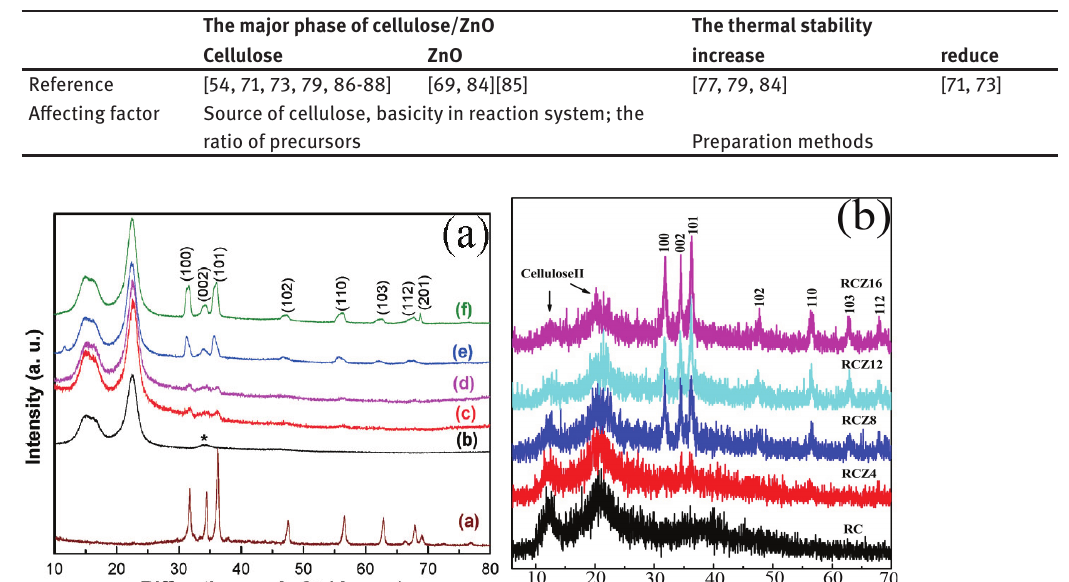
Table 2: The influence factors on major phase and thermal stability of cellulose/ZnO.